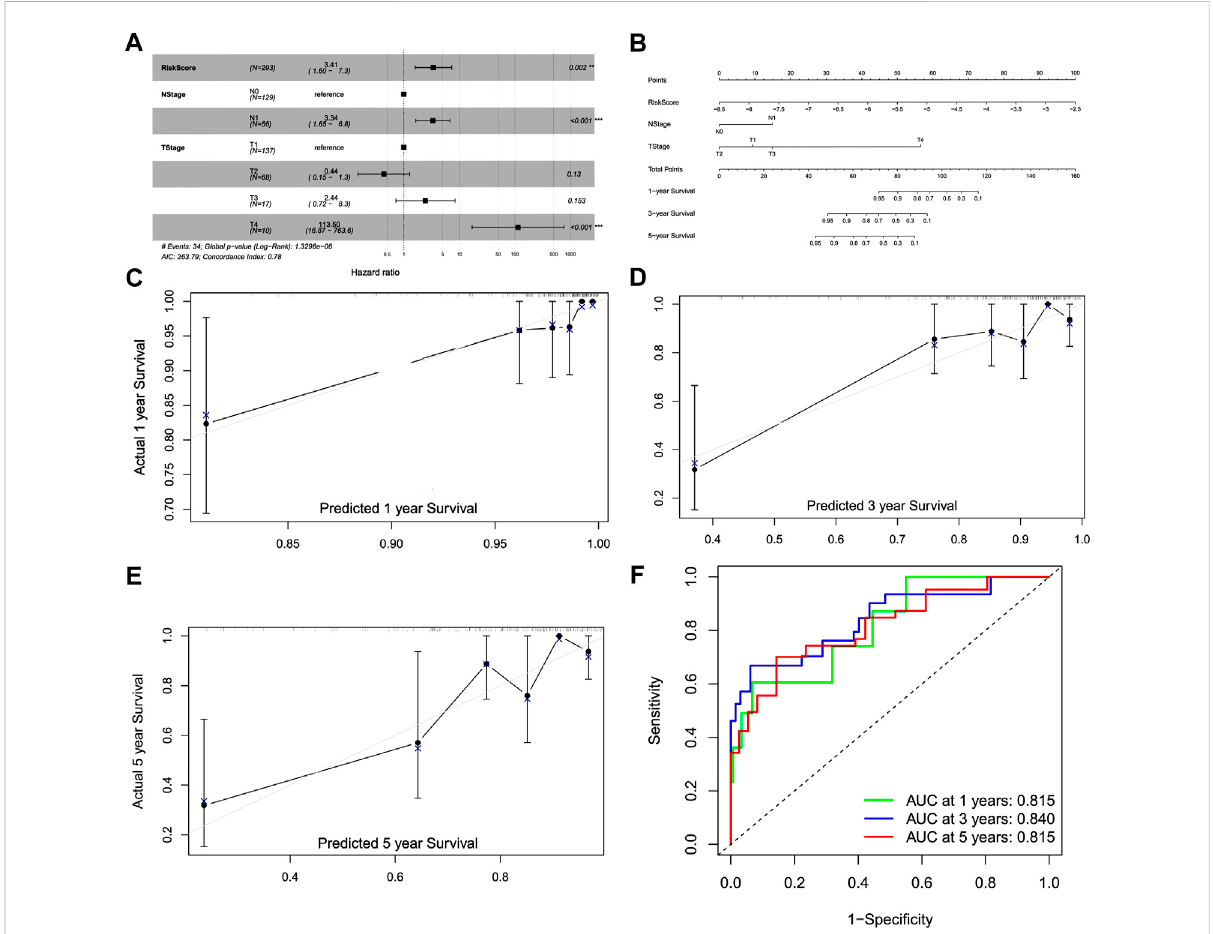
FIGURE 6 Constructionofaprognosticmodelandnomogram. (A) ForestplotofthemultivariateCoxmodel. (B) Nomogramfortheprognosticmodel. (C) Calibration curve for 1-year survival. (D) Calibration curve for 3-year survival. (E) Calibration curve for 5-year survival. (F) Receiver operating characteristic curve for 1-, 3-, and 5-year